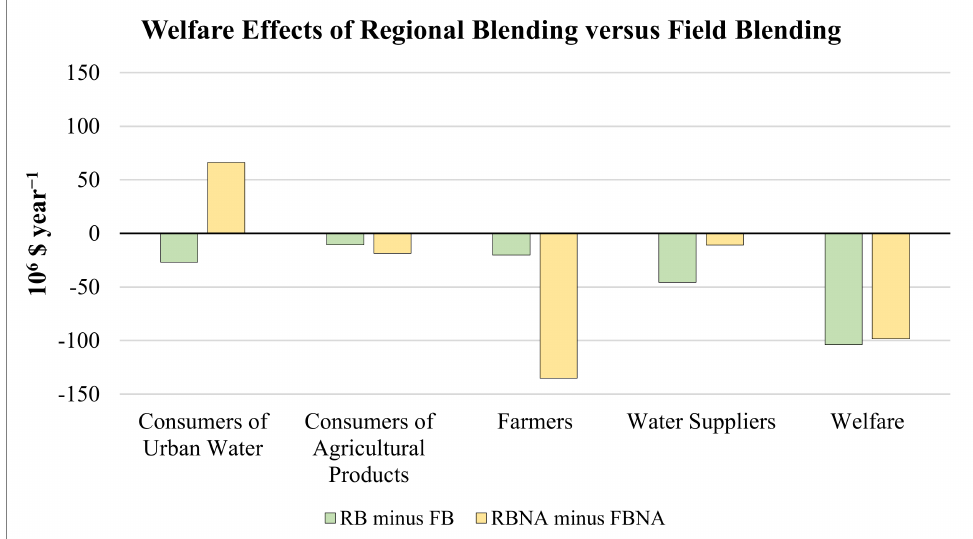
Figure 4. Differences in welfare elements computed under the field blending (FB) and regional blending (RB) scenarios when agricultural land adaptation is allowed (RB minus FB) and not allowed (RBNA minus